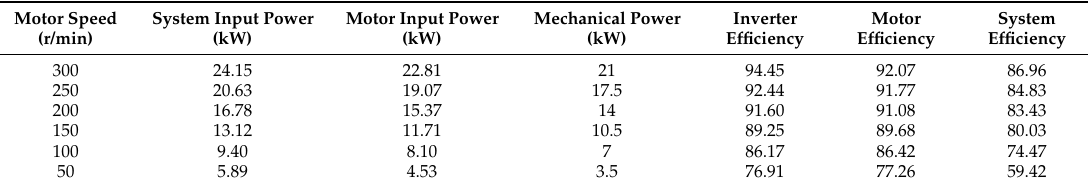
Table 5. Experimental results at rated torque in the system efficiency improvement control.